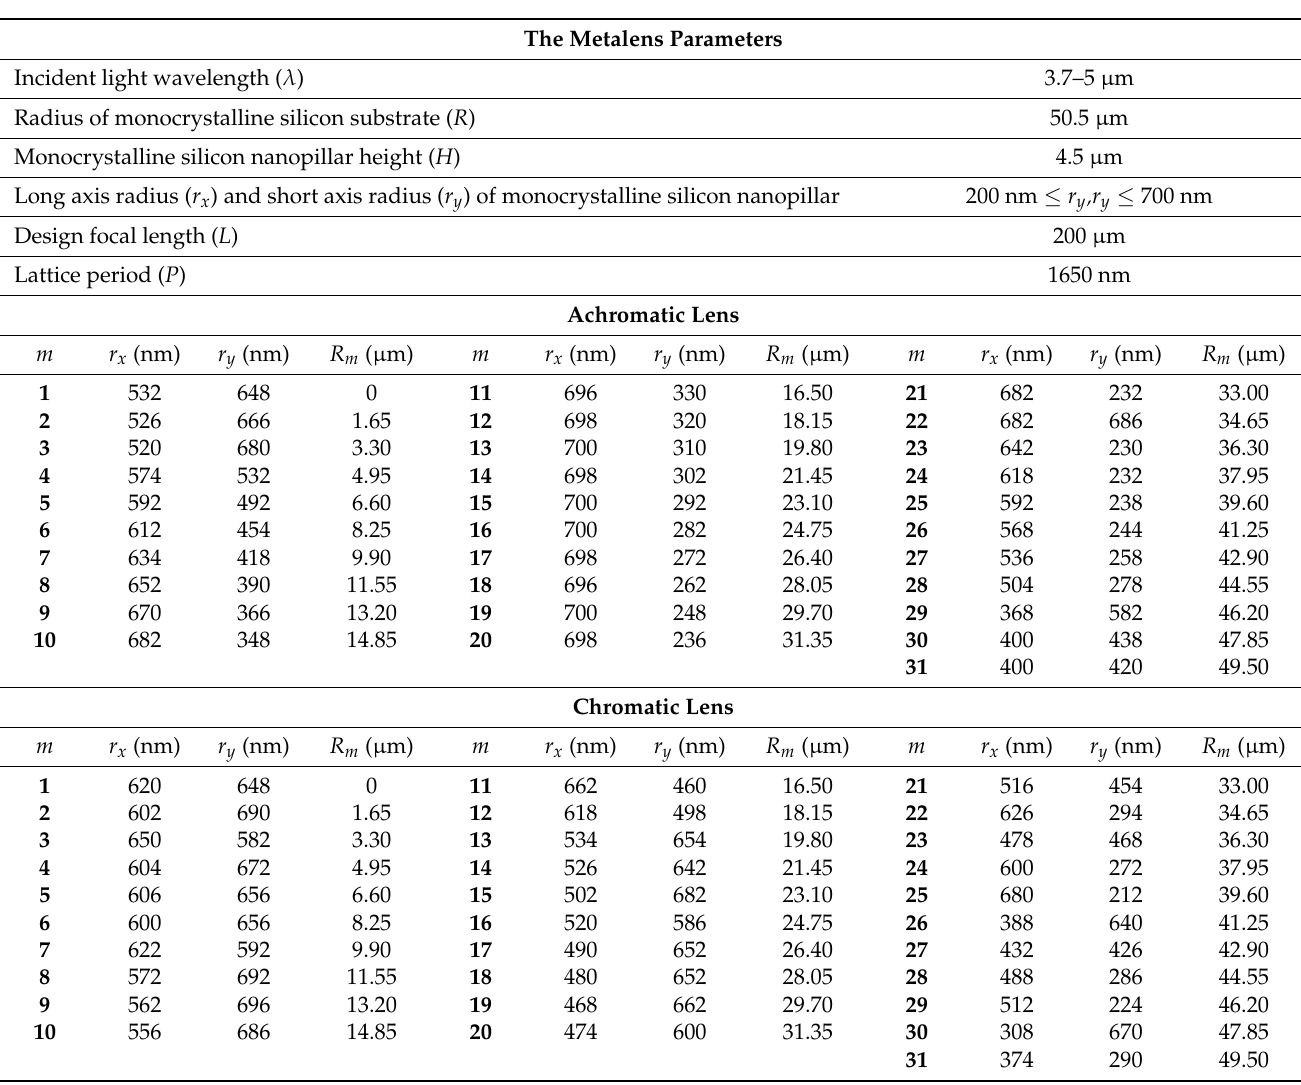
Table 3. The metalens parameters of unit cells for the achromatic lens and the chromatic